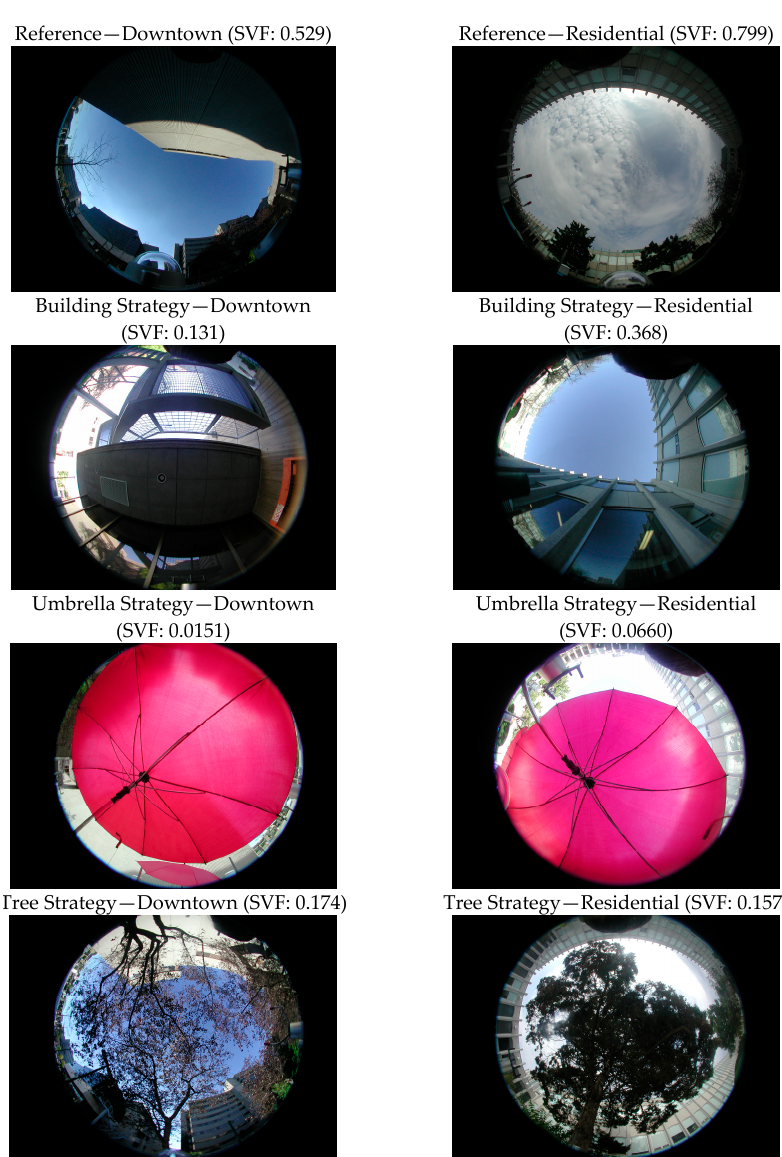
Figure 3. Hemispherical up photos taken facing up at each of the strategy and reference sites and approximate sky view factors (SVF). Sky view factors were calculated using the SkyViewFactorCalculator [32].